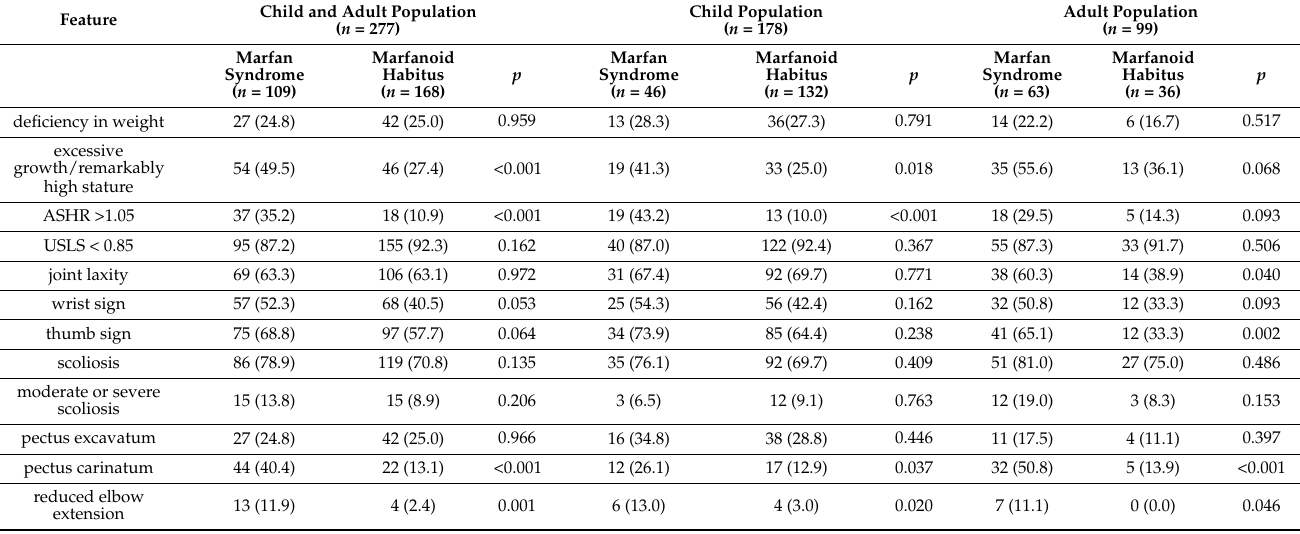
Table 2. Comparative analysis of the most frequently reported symptoms, physical examination abnormalities and other more frequently noted abnormalities between patients with MFS and mar- fanoid